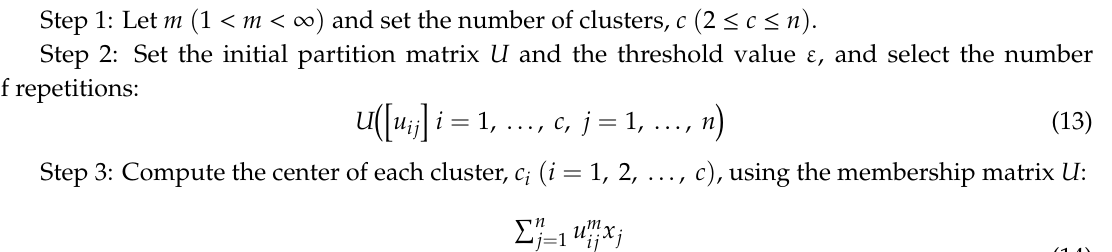
Figure 3. Comparison of clusters between fuzzy C-means (FCM) and context-based FCM clustering methods: ( a ) FCM clustering method and ( b ) Context-based fuzzy C-means (CFCM) clustering method.